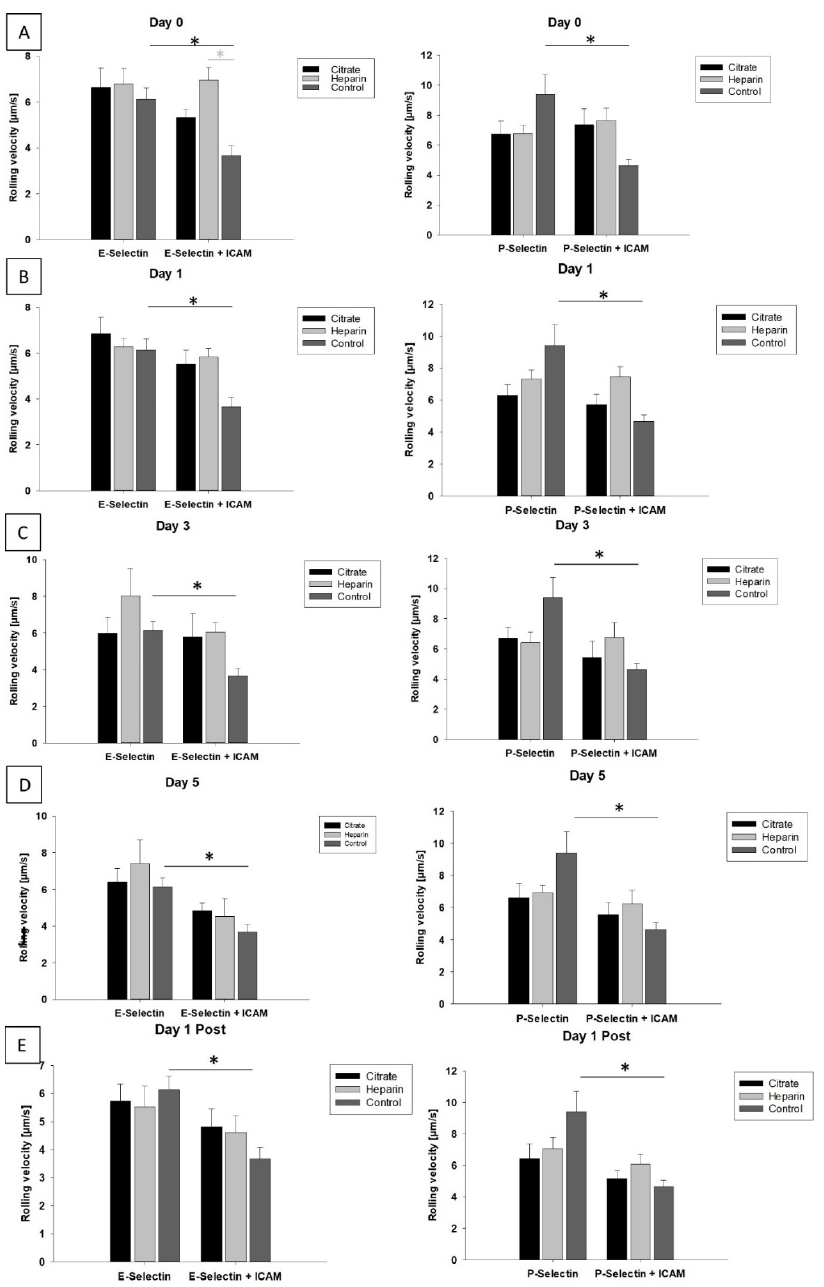
Figure 4. Leukocyte slow rolling in regional-citrate- and systemic-heparin-based CVVH. Sub-group analyses for systemic heparin vs. regional citrate slow leukocyte rolling were performed on day 0 ( A ), day 1 ( B ), day 3 ( C ), day 5 ( D ) and day 1 after CVVH discontinuation ( E ) and revealed no significant difference. T -test was performed for analysis of integrin response for each condition (shown as black bar and asterisk), where only the control subjects exhibited a significant ICAM-1-dependent reduction in rolling velocity, whereas this slow rolling response was not present in AKI patients. Light gray significance level in graphs represents results of in-group (either heparin vs. citrate vs. control in E-selectin or heparin vs. citrate vs. control in E + ICAM-1) analyses, tested by ANOVA. (n ≥ 3 individual patients; * p < 0.05; mean ±